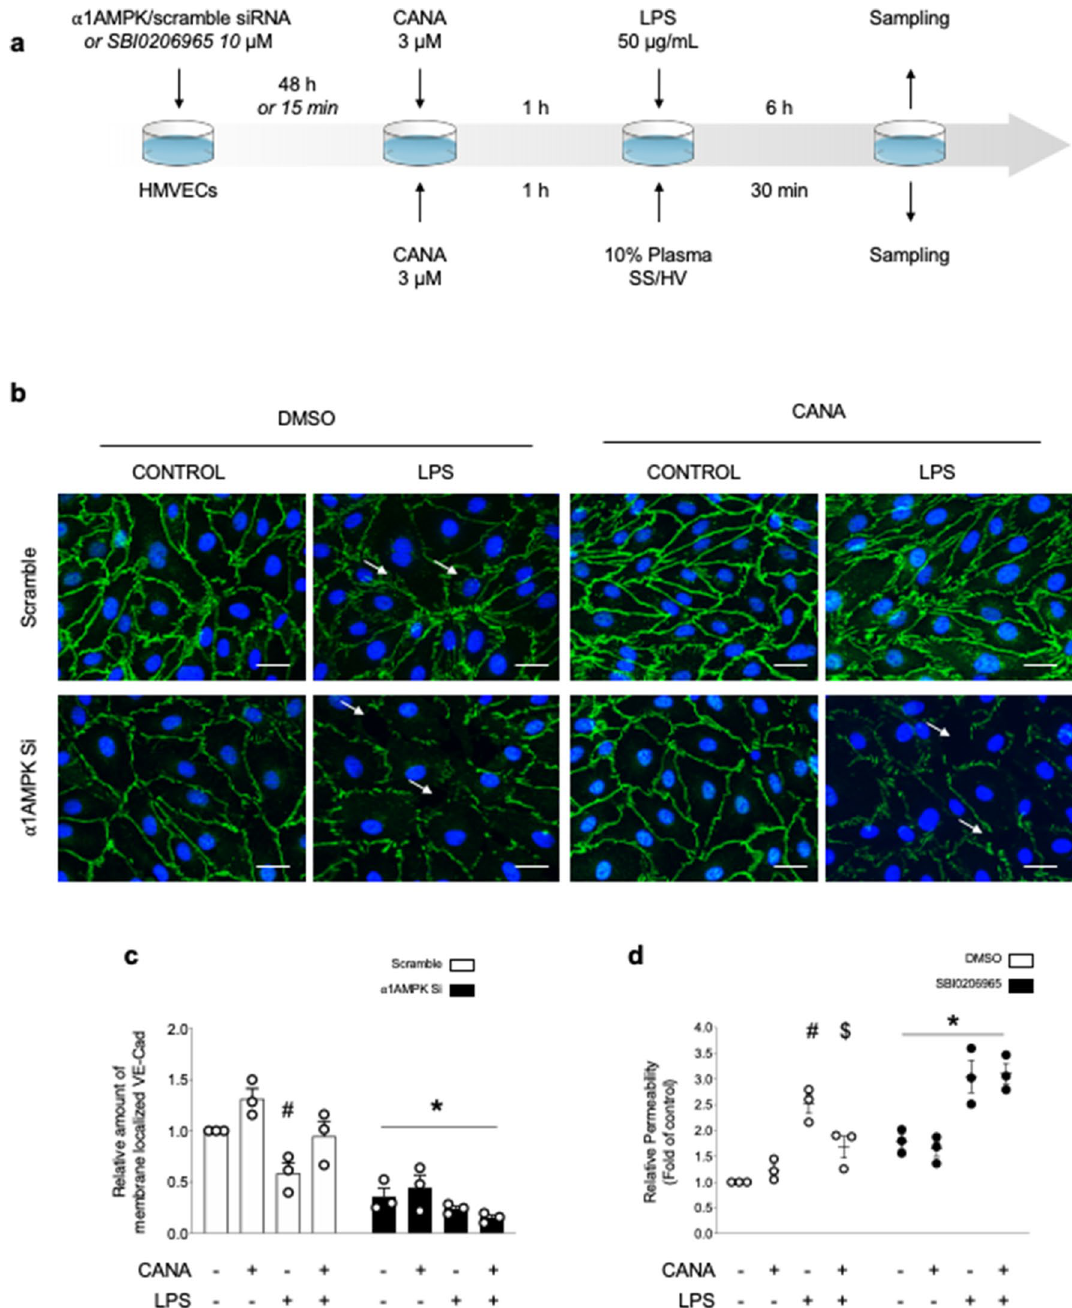
Figure 4. AMPK activation by Canagliflozin protects VE-Cad organization and endothelial barrier function against LPS injury. ( a ) Schematic representation of the experimental protocol. For ( b , c ), HMECs were transfected with scramble or ⍺ 1AMPK targeting siRNA (50 nM) for 48 h, then treated with canagliflozin (Cana) (3 µM) or DMSO for one hour, before adding lipopolysaccharide (LPS) or vehicle (50 µg/mL) for 6 h. For ( d ), SBI compound was incubated for 15 min, then canagliflozin (3 µM) or DMSO were incubated for one hour, before adding LPS (50 µg/mL) for 6 h. ( b , c ) VE-Cad immunostainings were performed on HMECs treated according to the protocol detailed in ( a ). Representative images ( b ) and quantifications ( c ) are shown. Intercellular gaps are indicated by white arrows. Nuclei were stained with DAPI. Scale bar, 50 µm. (d) Endothelial permeability in response to canagliflozin, LPS challenge, and AMPK inhibitor SBI0206965. HMECs were grown on gelatin-coated Transwell inserts for 72 h and treated according to the protocol detailed in ( a ). Data are expressed as mean ± SEM (3 biological replicates for each condition). # p < 0.05 is relative to respective non-treated HMECs, $ p < 0.05 is relative to LPS-only treated HMECs, and * p < 0.05 is relative to cells treated with DMSO. The data underwent two-way